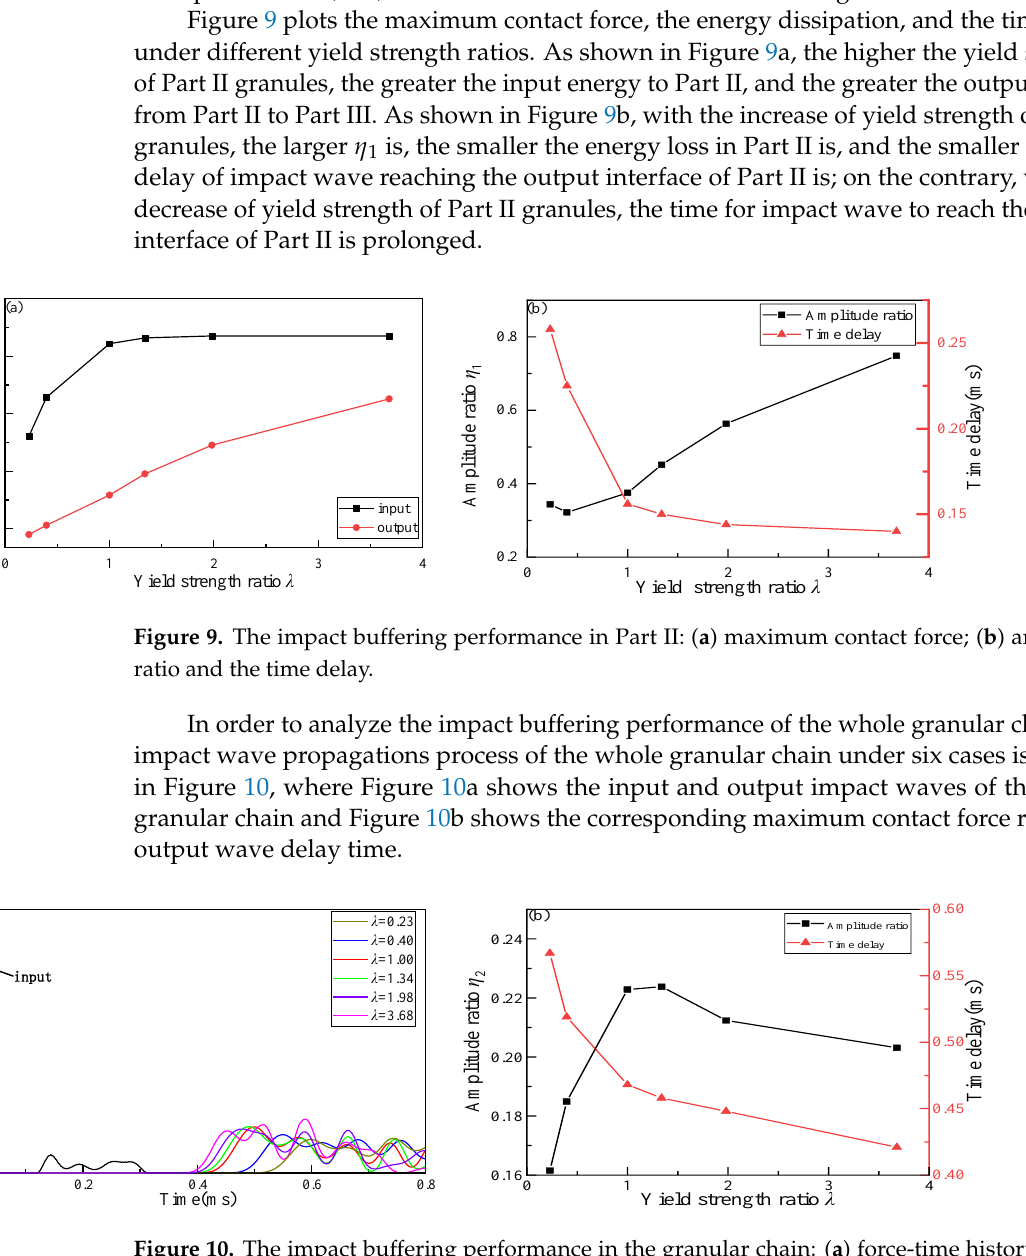
Figure 8. Contact force-time curves of Part II input interface and output interface under six cases.